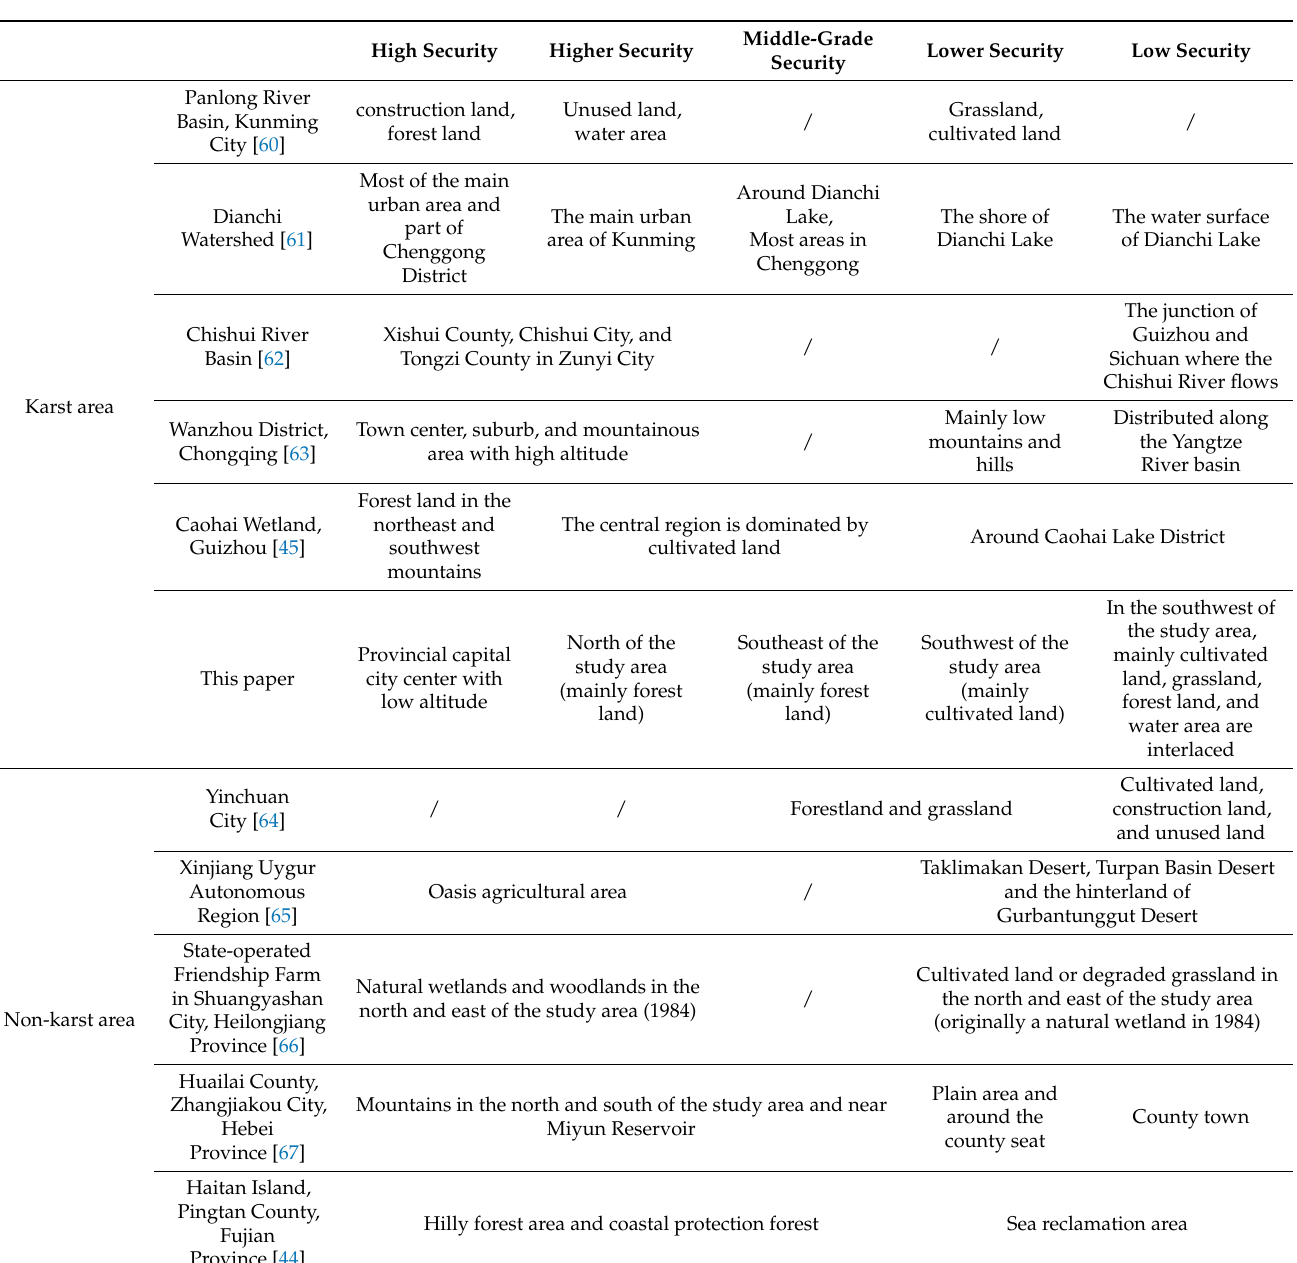
Table 2. Relevant study on ecological security of landscape